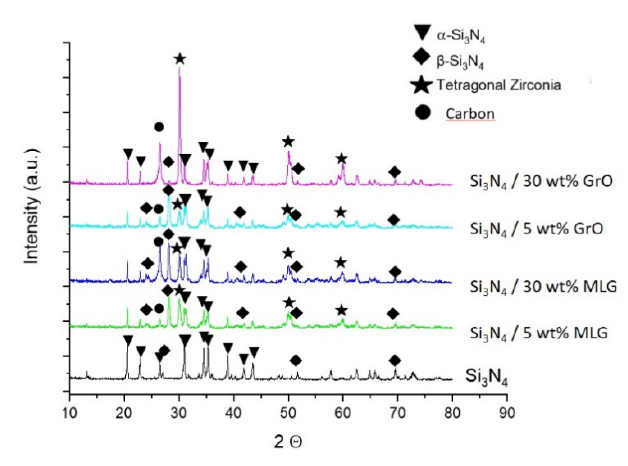
Figure 8. XRD analysis of Si 3 N 4 -based composites.